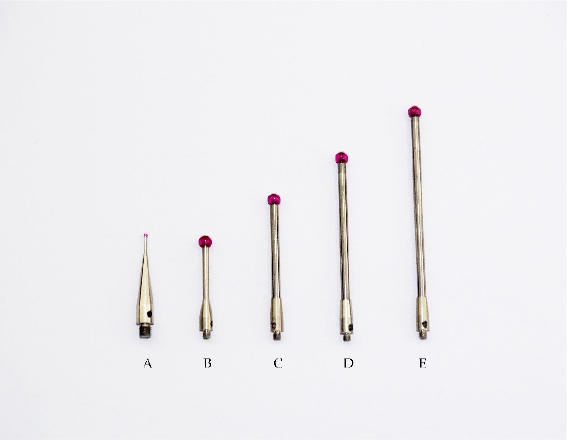
Figure 3. System composition diagram: ( a ) camera; ( b ) computer; ( c ) light pen.